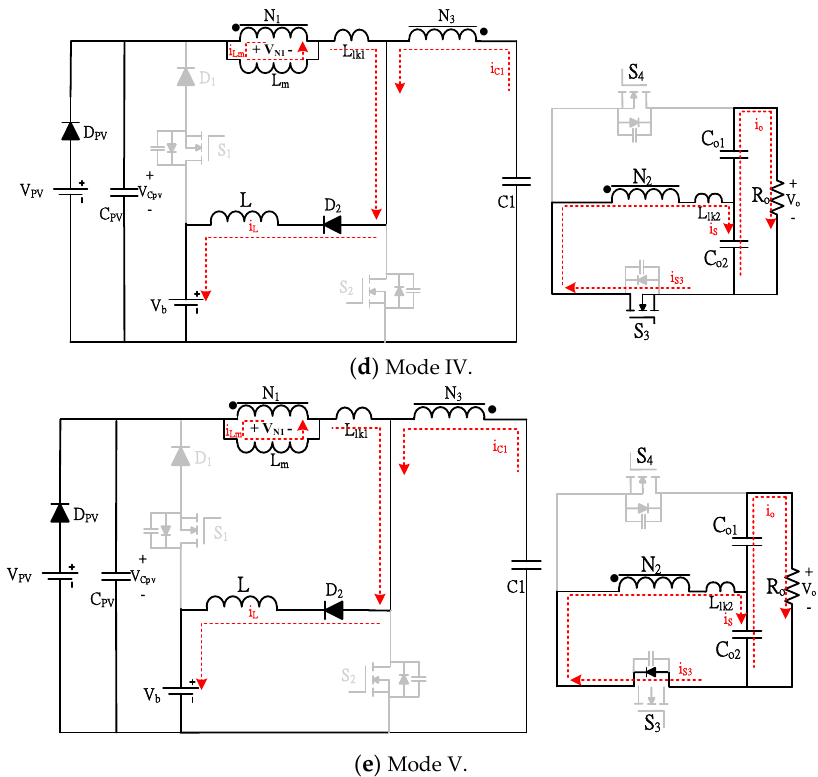
Figure 4. Operational diagram of each mode in Stage 1: ( a ) Mode I, ( b ) Mode II, ( c ) Mode III, ( d ) Mode IV, and ( e ) Mode V.